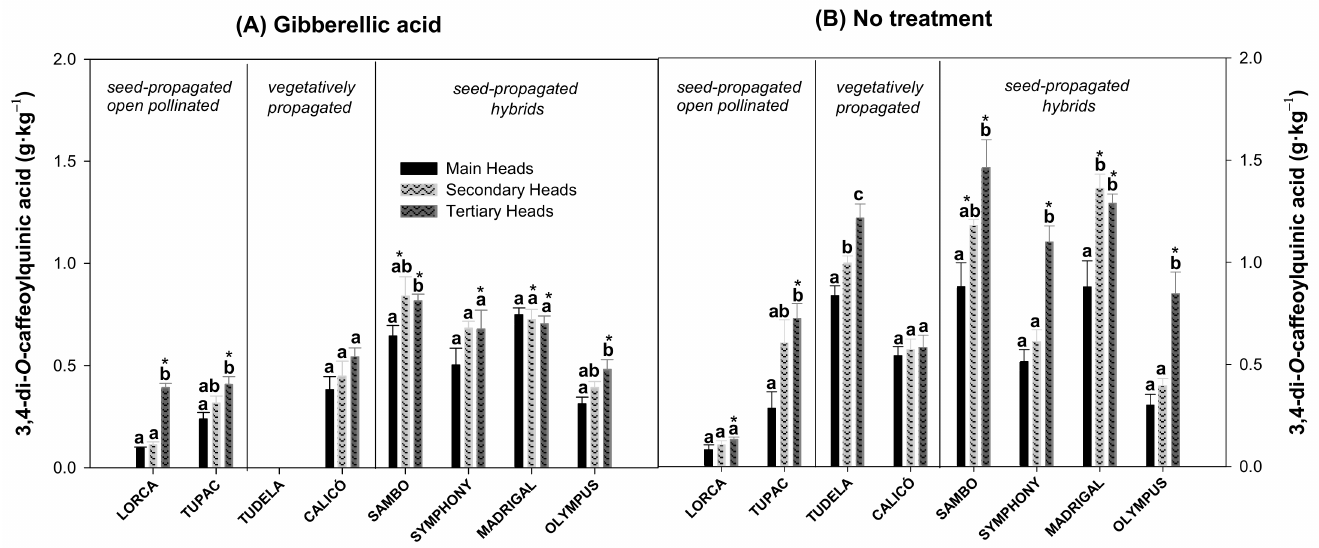
Figure 4. The 3,4-di- O -caffeoylquinnic acid content (g · kg − 1 ) of globe artichoke cultivars influenced by flower head order (main, secondary, and tertiary heads) and treatment (gibberellic acid ( A ) or no treatment ( B )). Data are the mean ± SE. Different letters show significant differences ( p < 0.05 according to HSD Duncan’s test) among flower head orders for each artichoke cultivar and treatment. Significant differences between both treatments ( p < 0.05 according to Student’s t -test) were expressed as * placed in each flower head order for each artichoke